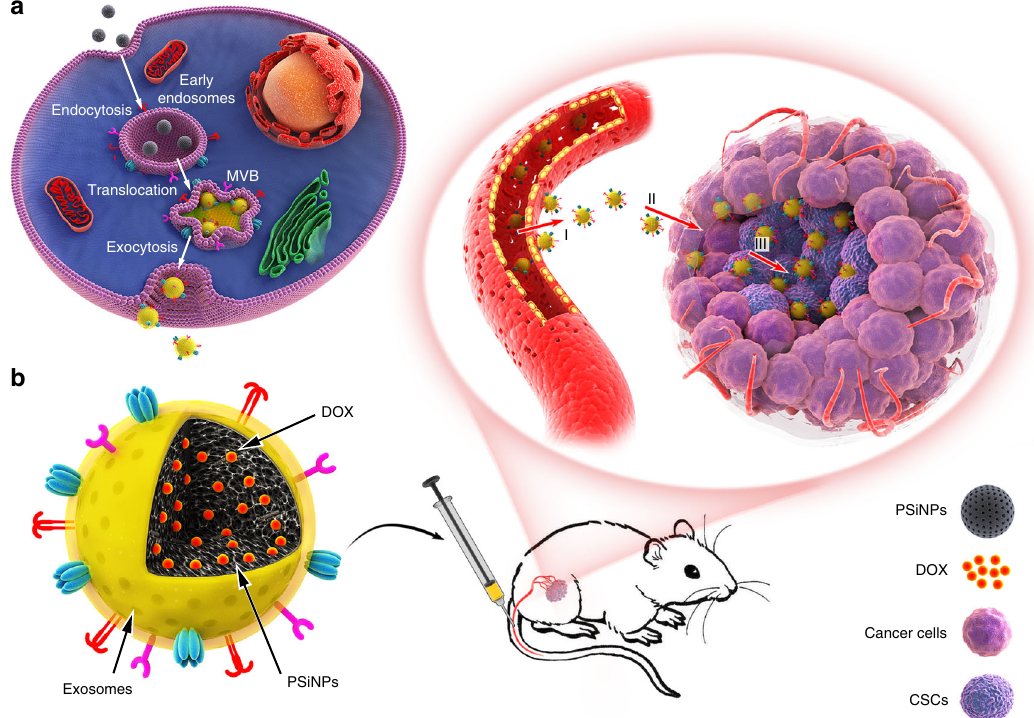
Fig. 1 Schematic illustration of E-PSiNPs as drug carriers for targeted cancer chemotherapy. a Schematic illustration of the preparation of DOX@E-PSiNPs. DOX@PSiNPs are endocytosed into cancer cells after incubation, then localized in multivesicular bodies (MVBs) and autophagosomes. After MVBs or amphisomes fuse with cell membrane, DOX@E-PSiNPs are exocytosed into extracellular space. b Schematics showing how DOX@E-PSiNPs effeciently target tumor cells after intravenous injection into tumor-bearing mice. (I) DOX@E-PSiNPs effeciently accumulate in tumor tissues; (II) DOX@E-PSiNPs penetrate deeply into tumor parenchyma; and (III) DOX@E-PSiNPs are ef fi cently internalized into bulk cancer cells and CSCs to produce strong anticancer ef fi